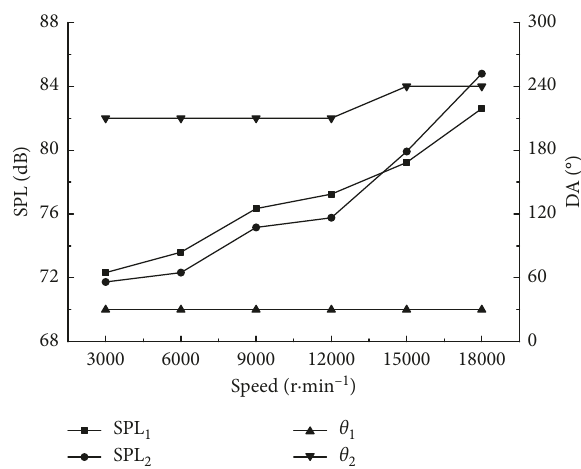
Figure 8: Variation trends of DAs and their SPLs with